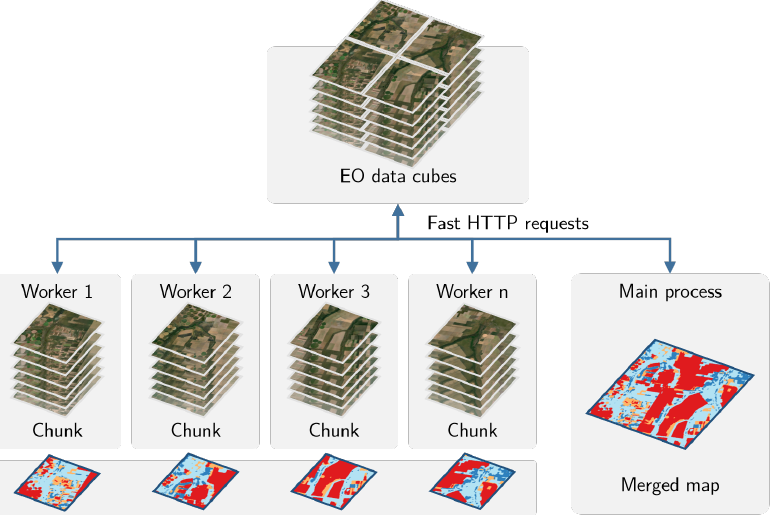
Figure 6. Parallel processing in sits (source: